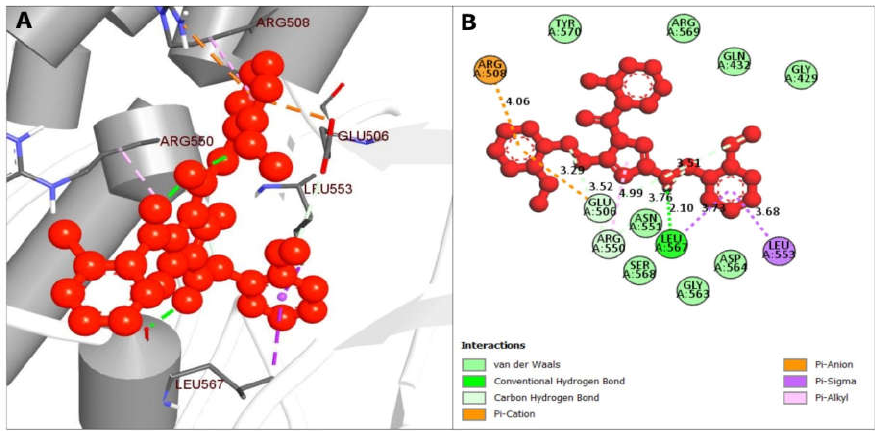
Figure 6. The non-bonded interaction of the CID16355541 and main protease from FAK1 at certain simulation times. Herein, ( A ) representing the 3D protein-ligand interaction and ( B ) representing 2D interaction of the protein with the ligand. The compound CID16467343 and FAK1 protein complex formed three conventional hydrogen bond bonds at LEU567, and three carbon hydrogen bonds at ARG550, ARG550 and GLU506 position. The Pi-Cation, Pi-Anion and Pi-Sigma bond the positions of ARG508, GLU506, LEU553, and LEU567, respectively (Figure 7; Table 3).